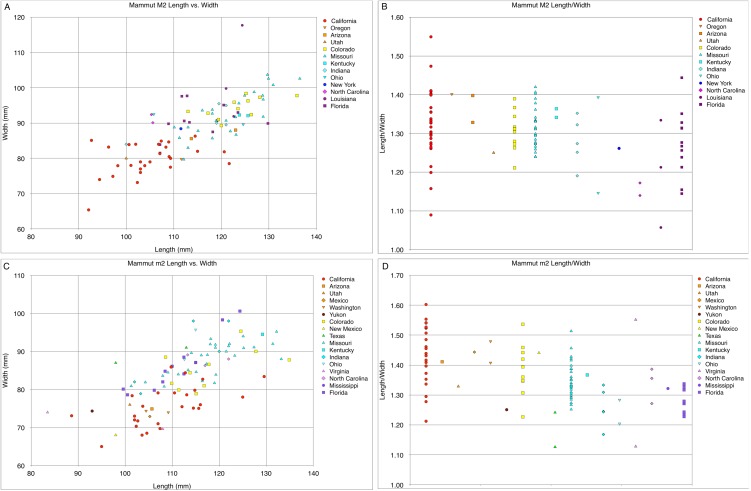
Length and width comparisons of Mammut M2 and m2, by state/province/country.(A) Length vs. width of Mammut M2. M. pacificus is indicated in red, (B) length/width of Mammut M2, organized by state. M. pacificus is indicated in red, (C) length vs. width of Mammut m2. M. pacificus is indicated in red, and (D) length/width of Mammut m2, organized by state. M. pacificus is indicated in red. Note that in (B) and (D), there is little difference in the L:W values between any of the locations, including California. This indicates that M2/m2 proportions do not differ between M. pacificus and M. americanum.